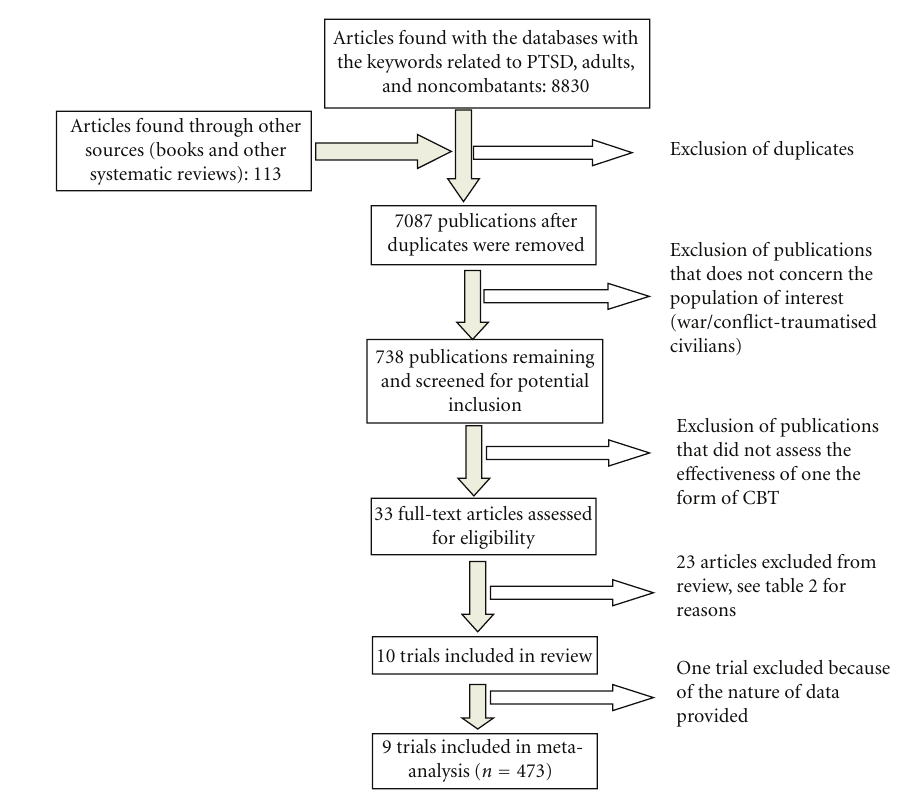
Figure 1: Flow chart of the systematic